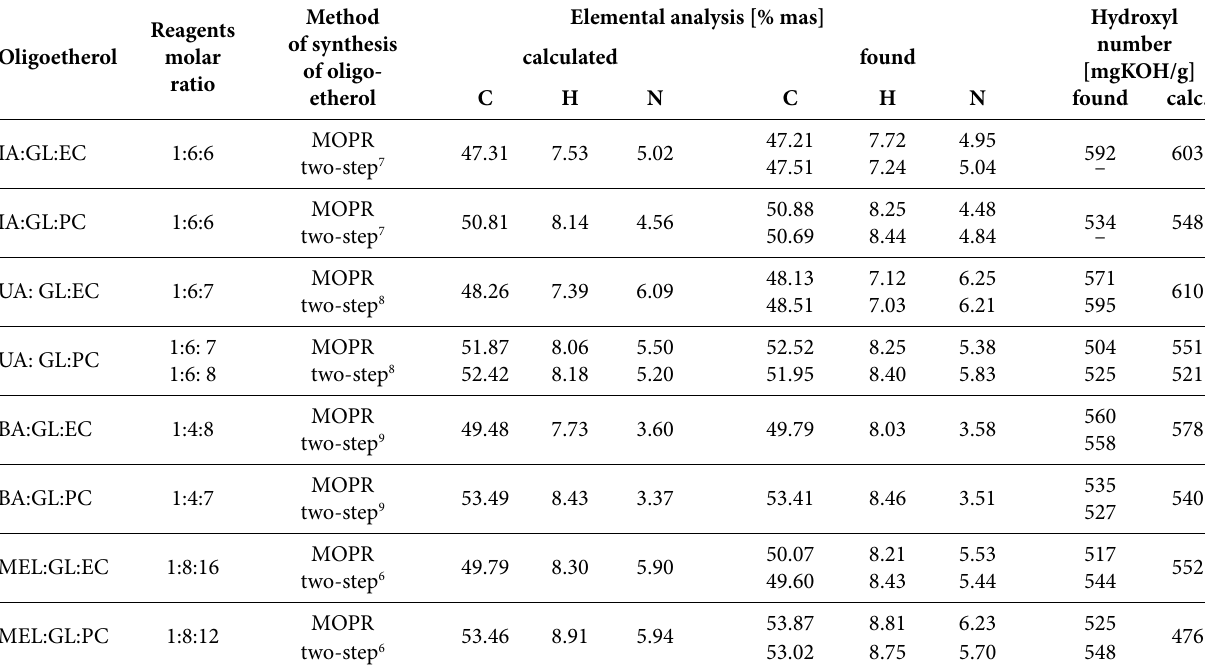
Table 2. Elemental analysis and hydroxyl number of oligoetherols obtained in MOPR and two-steps reactions 6–9